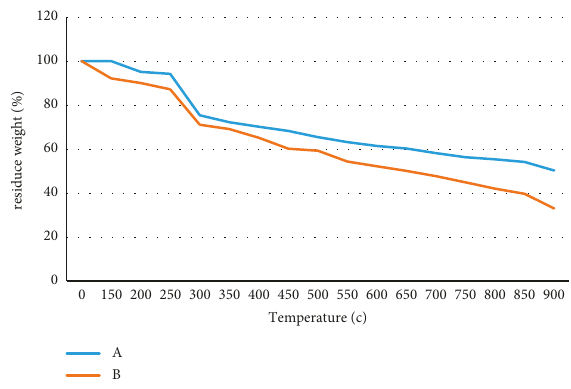
Figure 10: Comparison of thermal stability of